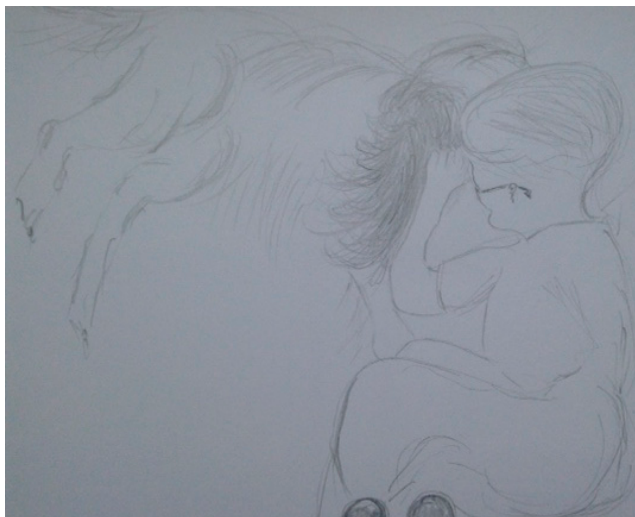
Figure 3. Timmy and Ted face to face with rhythmic ear stroking, and Ted responding by nuzzling into Timmy’s hair and face.